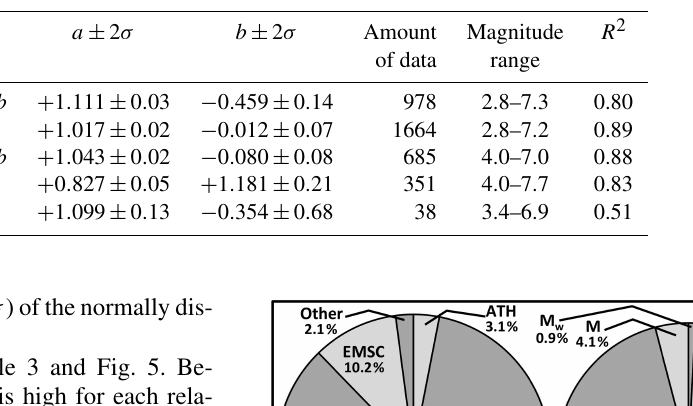
Table 3. Equivalent moment magnitude ( M ∗ w ) relations for different magnitude scales.